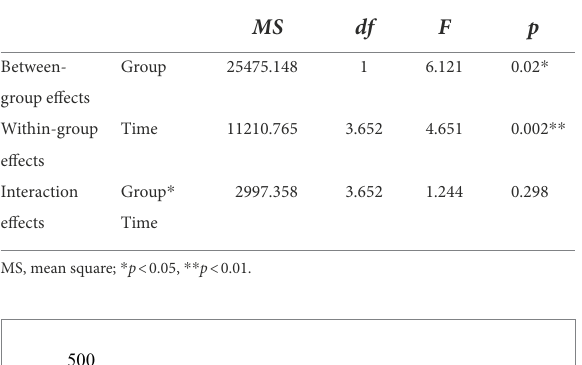
TABLE 8 Repeated measures analysis of variance for total sleep time.